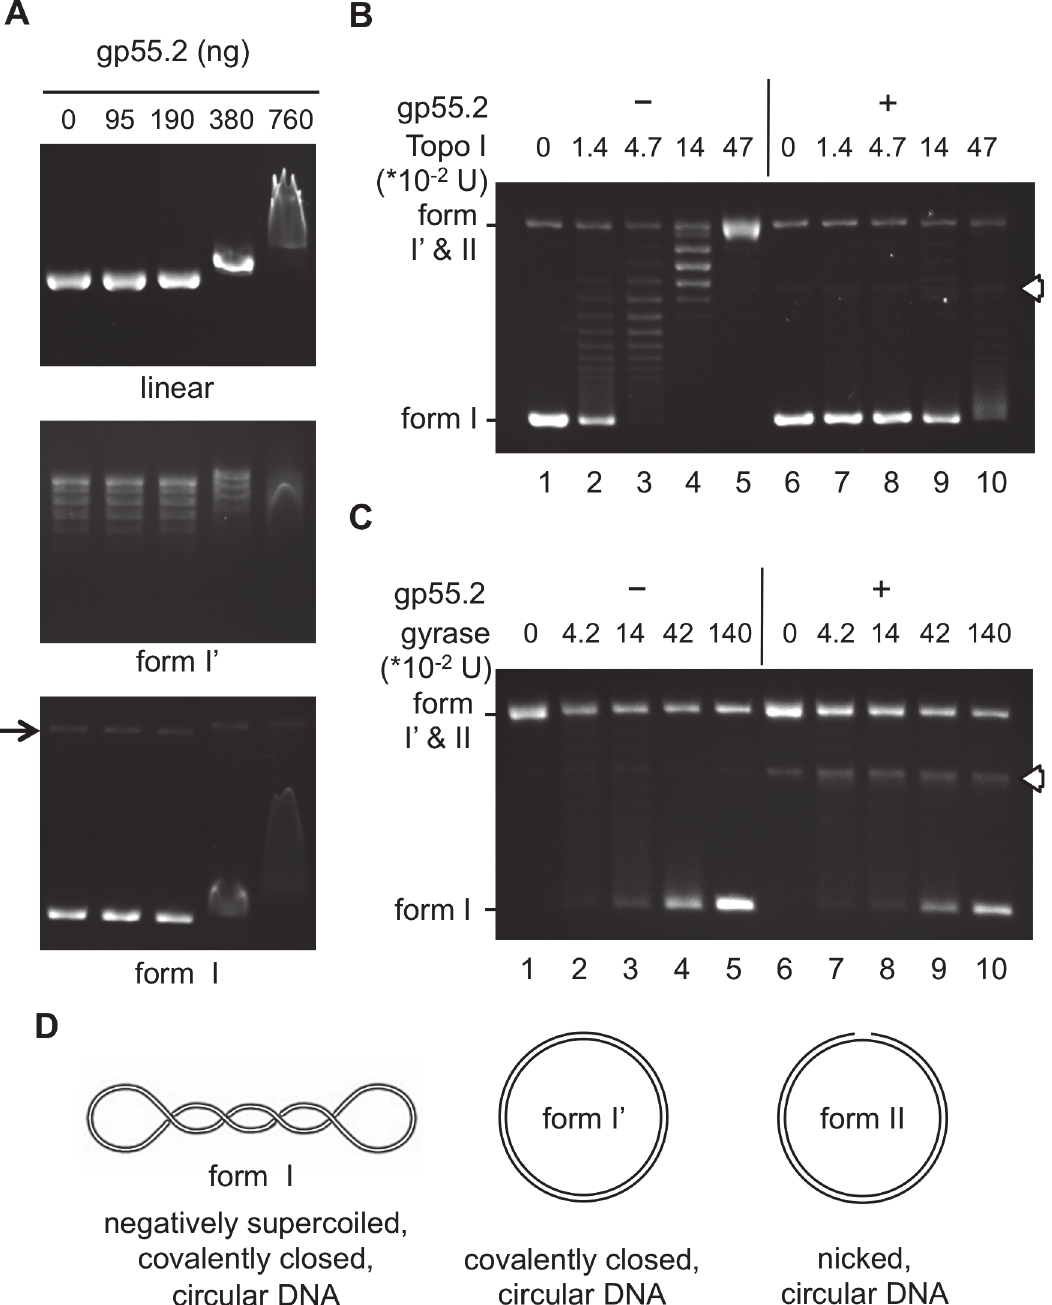
Fig 3. Gp55.2 binds to DNA, inhibits Topo I relaxation activity but does not affect DNA gyrase supercoiling activity. (A) Electrophoretic mobility shift assays (EMSA). Mixtures containing 300 ng (= 79 fmol) of linear, form I ’ , or form I pDB29 DNA and the indicated amount of gp55.2-His 6 (95 ng = 6.9 pmol, namely one gp55.2 molecule per 65.6 bp for the amount DNA used in this assay) were incubated and analyzed as described in Materials and Methods. An arrow indicates the migration position of the form II DNA contaminating the form I DNA. (B) Relaxation assays mixtures containing 600 ng (= 158 fmol) form I pDB29 DNA and the indicated units of Topo I (0.47 U = 415 fmol) were incubated in the presence (+) or absence ( – ) of 855 ng of gp55.2-His 6 (= 63 pmol, one gp55.2 molecule per 14.5 bp of DNA), and the DNA products were analyzed as described in Materials and Methods. The migration positions of form I, form I ’ and form II DNA are indicated on the left; linear DNA migration position is indicated by an arrowhead. Results representative of two independent experiments are shown. (C) Supercoiling assays mixtures containing 158 fmol form I ’ pDB29 DNA and the indicated units of DNA gyrase (0.42 U = 196 fmol) were incubated in the presence (+) or absence ( – ) of 855 ng of gp55.2-His 6 and the DNA products were analyzed as described in the Materials and Methods section. Results representative of two independent experiments are shown. (D) Representation of form I, form I ’ and form II plasmid DNA. Note that the treatment of form I plasmid DNA by a eukaryotic Topo I to obtain form I ’ DNA results, at equilibrium, in a distribution of relaxed DNA topoisomers (A, middle panel) whose maximum corresponds to the fully relaxed form I ’ plasmid illustrated in D. doi:10.1371/journal.pone.0124309.g003 PLOS ONE | DOI:10.1371/journal.pone.0124309 April 14,